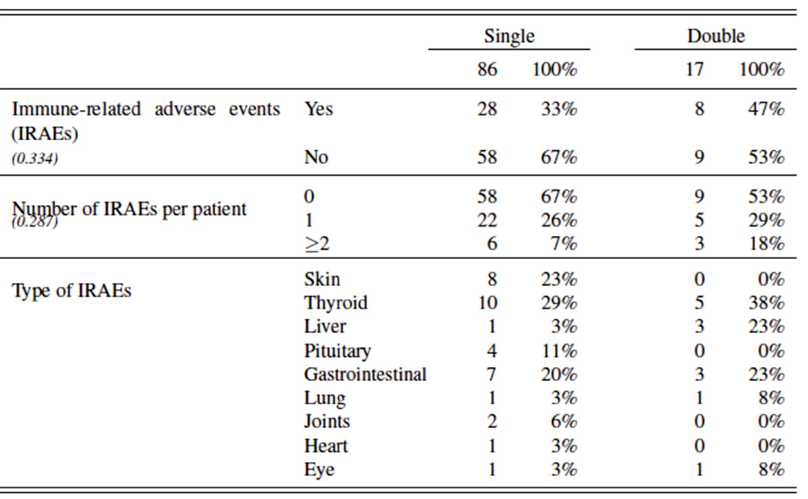
Figure 4. Immune-related adverse events in all included patients with advanced melanoma treated with single versus double ICI.